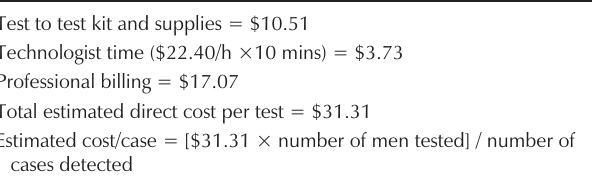
Specific costs estimated for screening of men attending a sexually transmitted disease clinic Test to test kit and supplies =